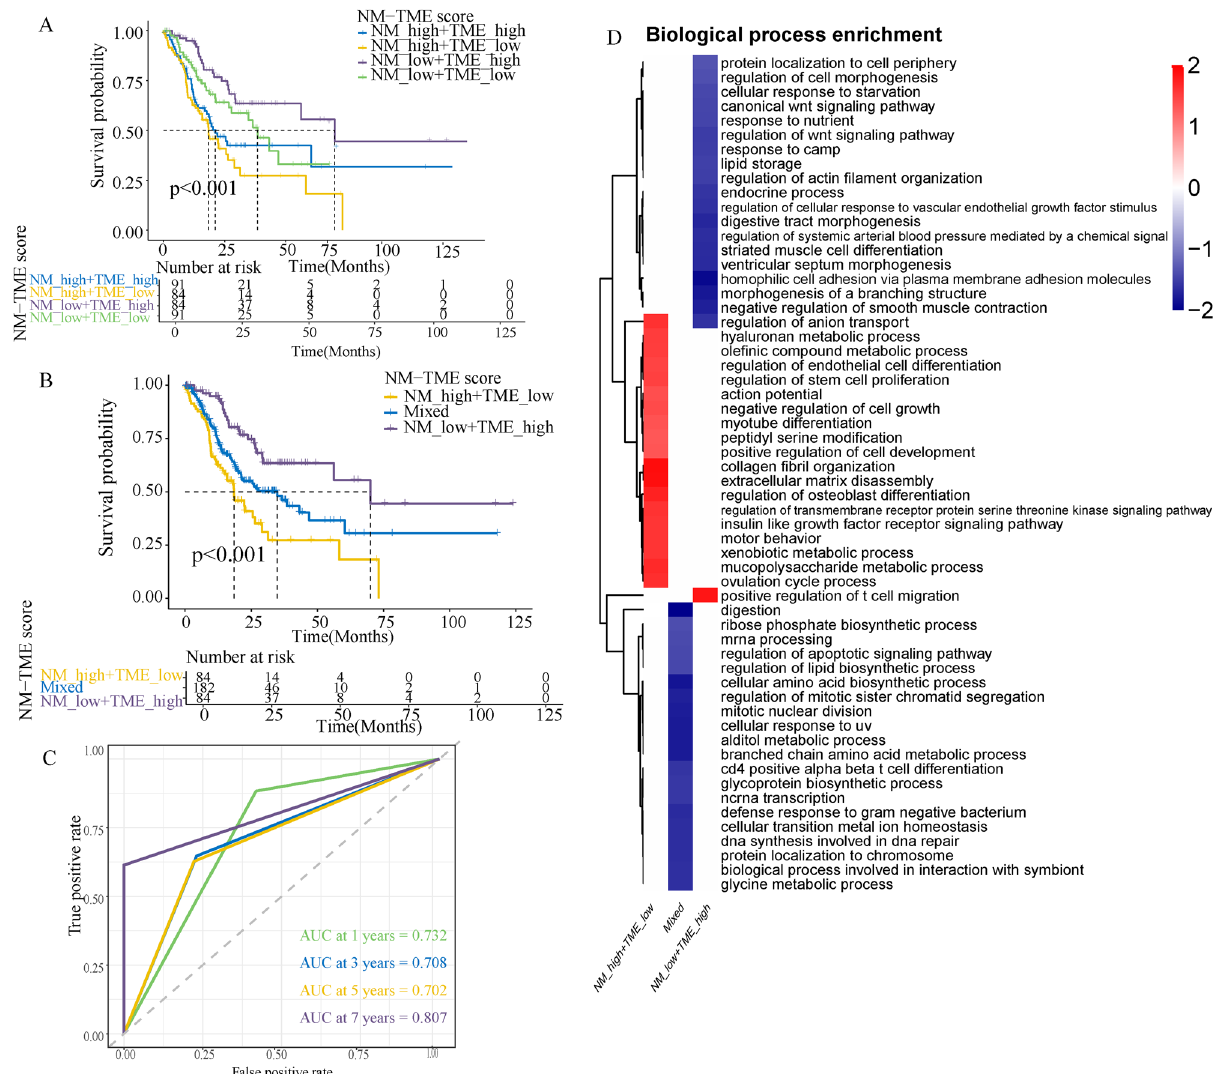
NM-TME classifier. NM nucleotide metabolism, TME tumour